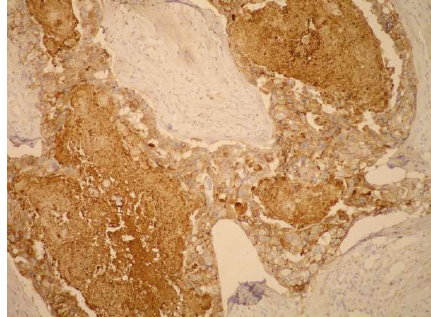
Figure 1: Strong epithelial (both membranous and cytoplasmic) Sdc1 expression and the absence of the stromal Sdc1 expression, with the accumulation of Sdc1 in the intraluminal necrotic tumor mass, IDC (IHC, × 100).